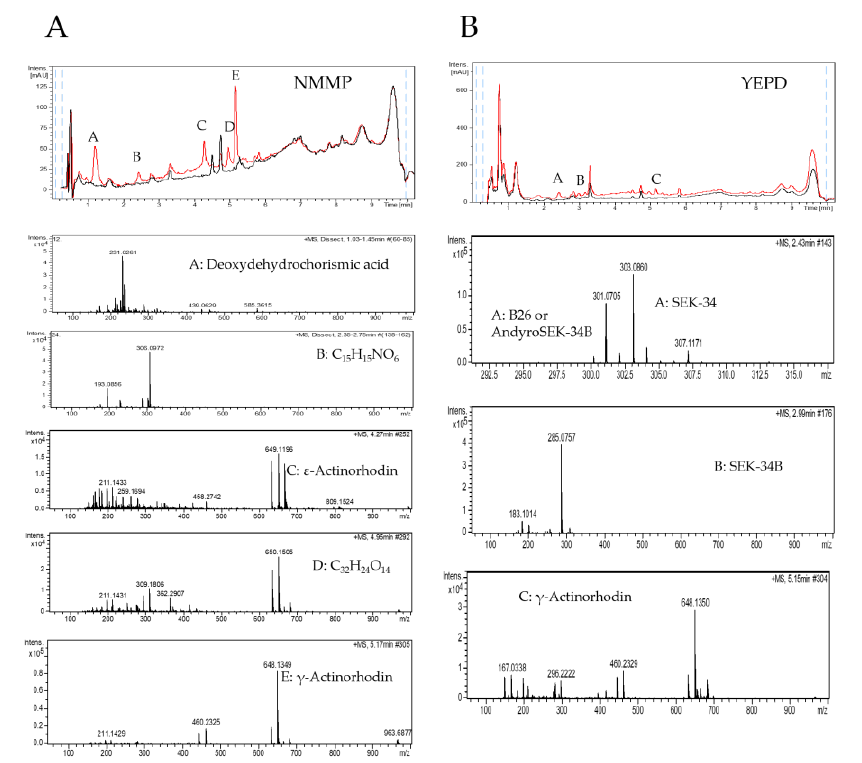
Figure 2. Analysis of the metabolites produced by S. coelicolor M145 grown in NMMP ( A ) or in YEPD ( B ) with water (black) or with SAP (red) and detected by UV/Vis absorbance (200 – 900 nm). Mass spectra of compounds in the differential peaks.